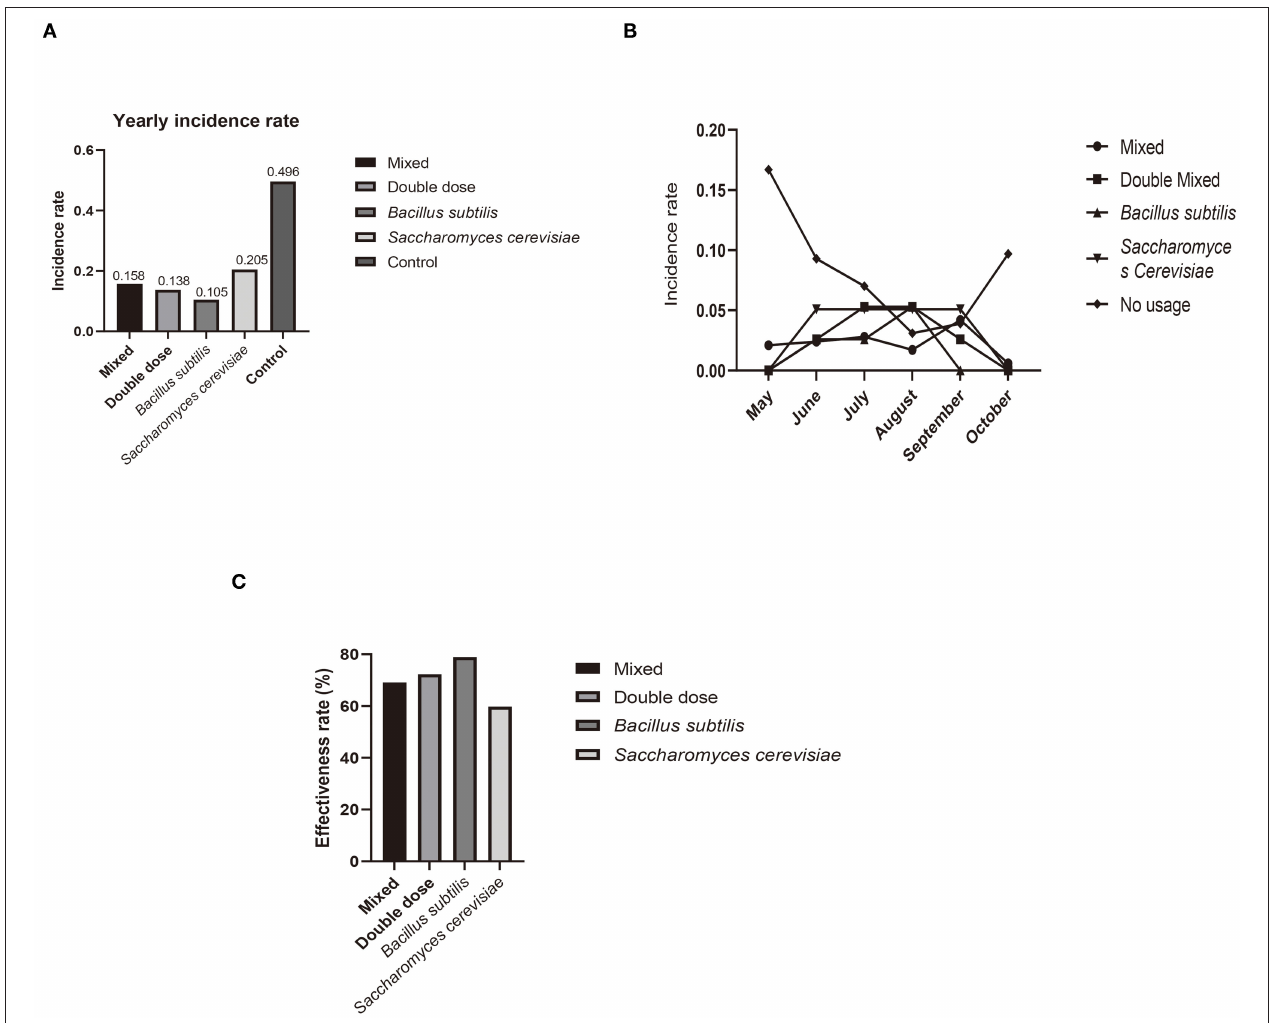
FIGURE 2 | (A) Yearly incidence rate of skin disease compared to all four experiment groups and control. (B) Incidence rate each month, with peak in May and October not observed in all experimental groups. (C) Effectiveness of treatment in each experimental group (compared to control). Former three groups showed a high level of effectiveness groups.